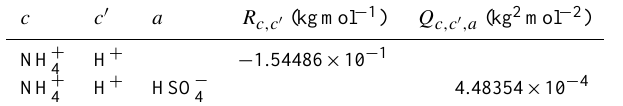
Table 6. Fitted special middle-range parameters representing non- zero cation ↔ cation and cation ↔ cation ↔ anion interactions. R c,c 0 and Q c,c 0 ,a parameters of all other ion interactions are set to zero. R c,c 0 and Q c,c 0 ,a are symmetric parameters, i.e., R R H + , NH + 4